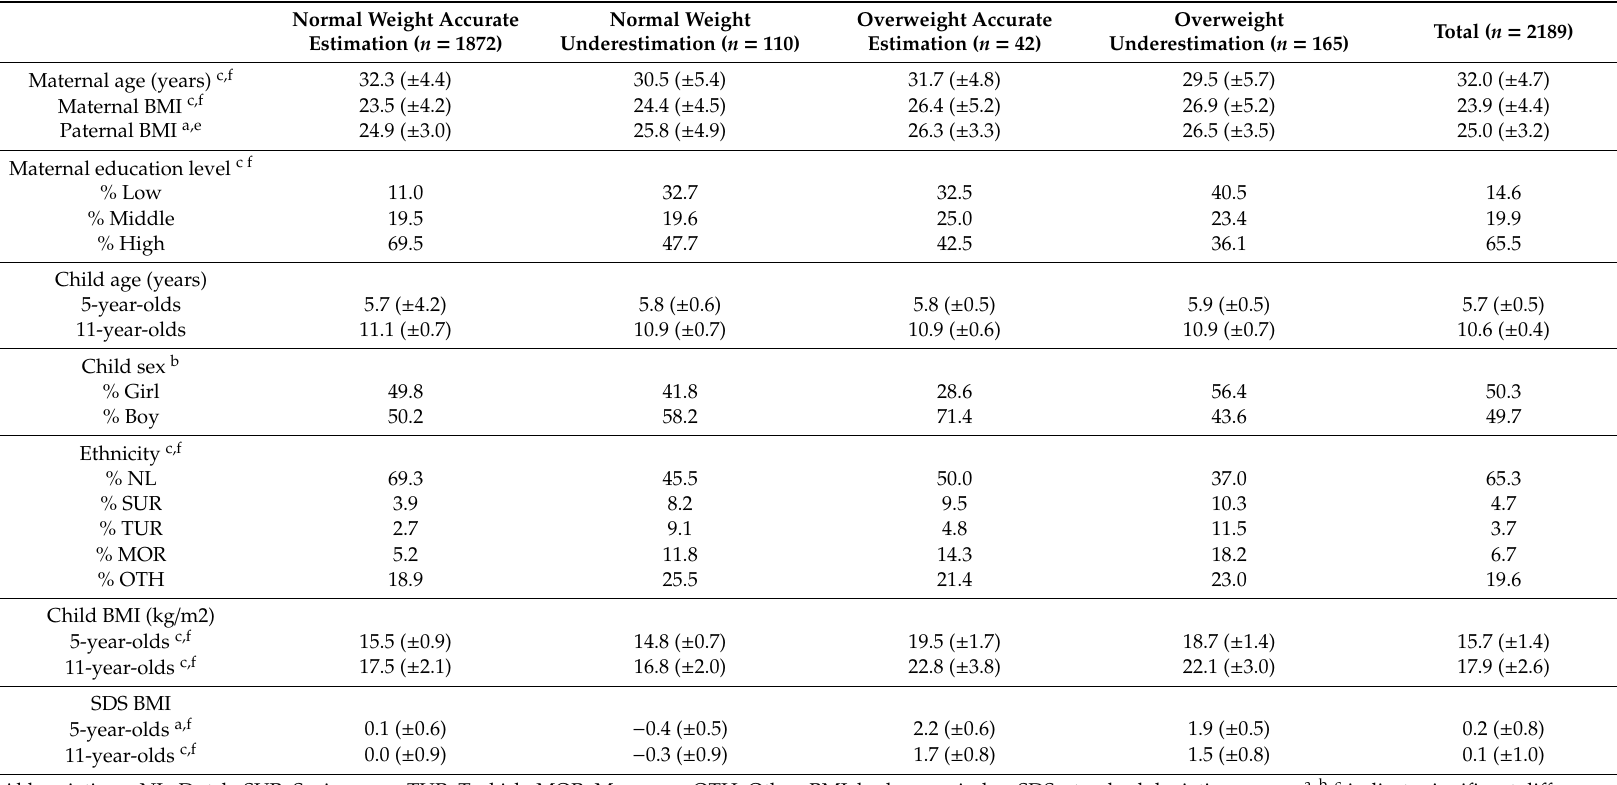
Abbreviations: NL, Dutch; SUR, Surinamese; TUR, Turkish; MOR, Moroccan; OTH, Other; BMI, body mass index; SDS, standard deviation scores. a,b,c indicate significant di ff erences between the normal and overweight group at the level of p < 0.05, p < 0.01, and p < 0.001, respectively. d,e,f indicate significant di ff erences between accurately estimated and underestimated groups at the level of p < 0.05, p < 0.01, and p < 0.001,